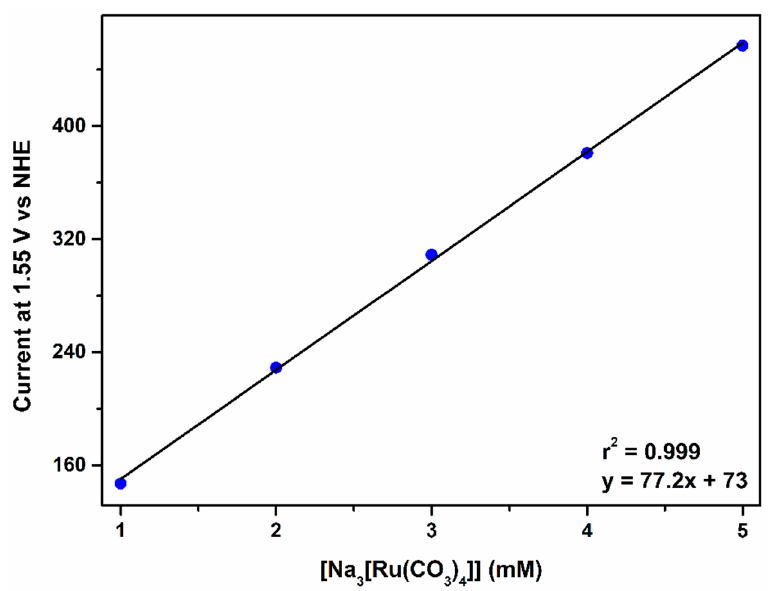
Figure 10. A linear increase of the catalytic peak current at 1.55 V vs. [Na 3 [Ru 2 ( µ -CO 3 ) 4 ]]. The voltammograms are recorded in 0.10 M NaHCO 3 (pH 8.3) under N 2 atmosphere with a scan rate of 50 mV · s − 1 . The catalytic peak/plateau current also depends linearly on [HCO 3 − ] (Figure 11 and Figure S11).